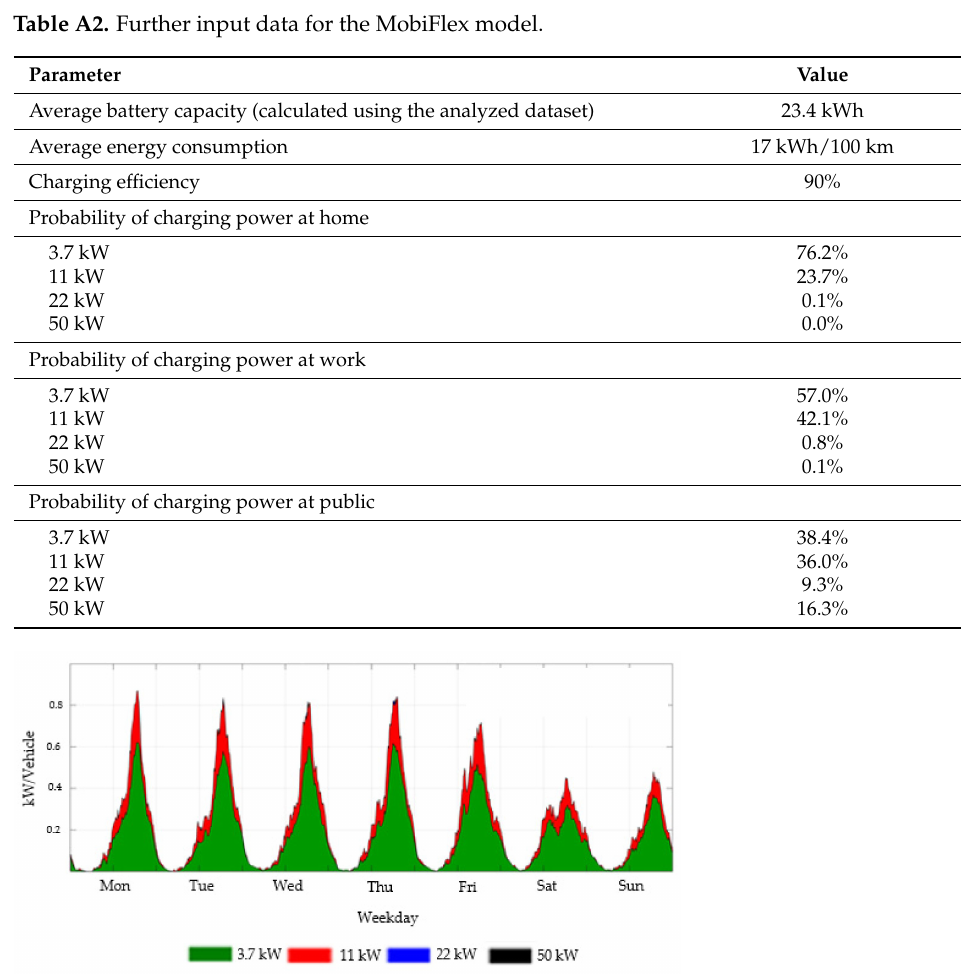
Figure A16. Charging patterns for uncontrolled charging for “home charging”. The charging pattern of this configuration, the load peaks in the evening and the used charging power showed a congruence with User Group A (cf. Figure A11a). The second configuration examined the case where only public charging was possi- ble. The resulting charging pattern (Figure A17) showed similarities with User Group E (Figure A15a). There were two peaks on weekdays and one main peak on Saturday morning. However, the MobiFlex model did not show any overnight charging.